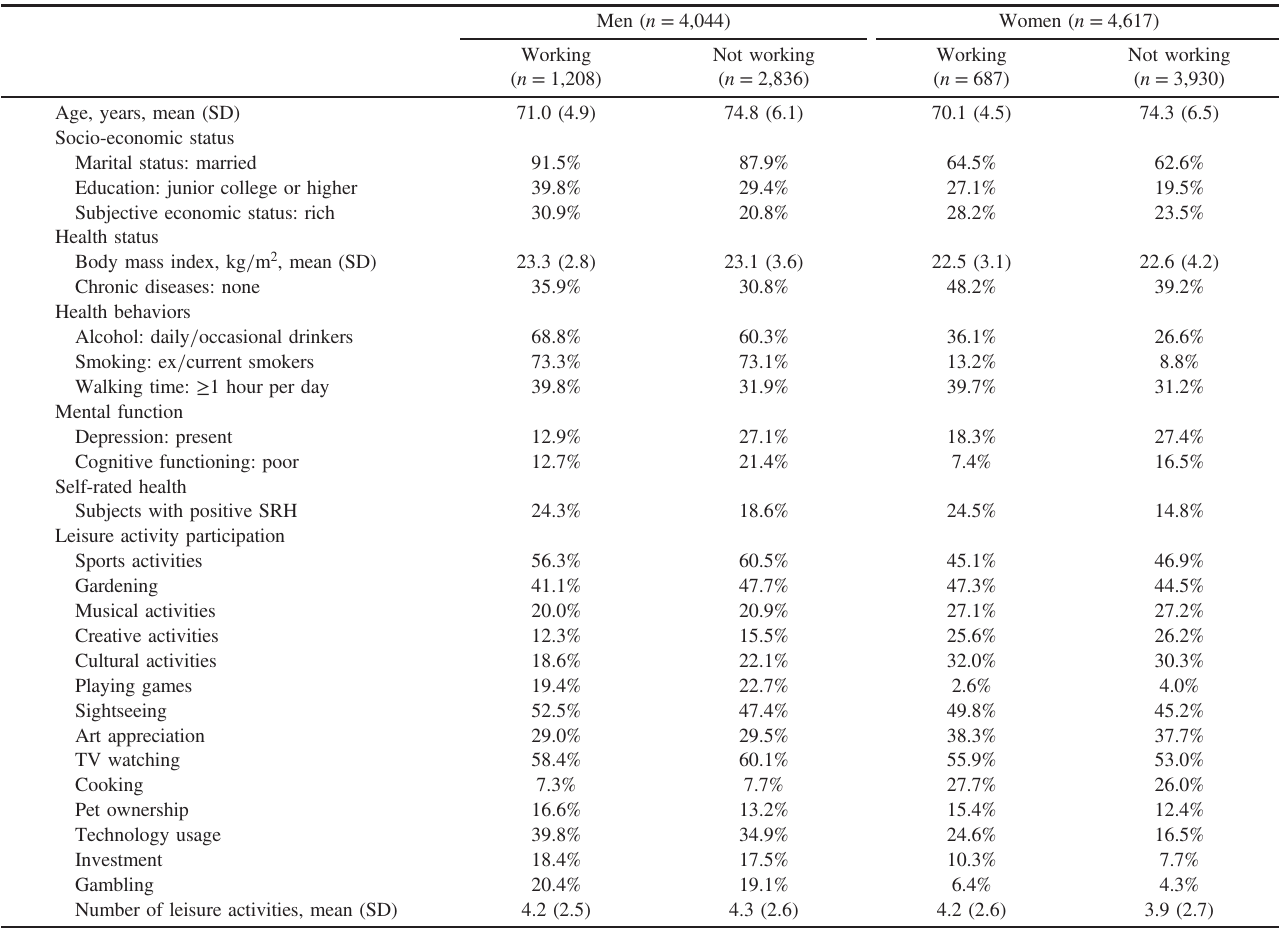
Table 2. Characteristics of study participants according to gender and work status